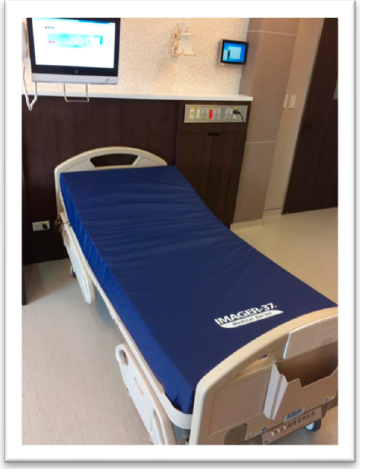
Figure 1. Whiz Pad is a foam mattress capable of motion